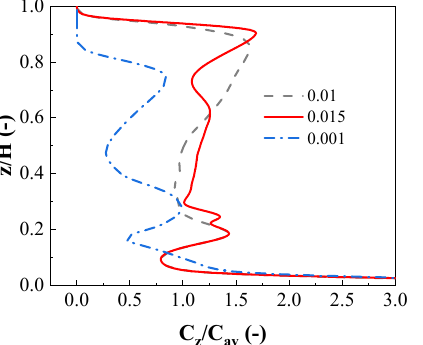
Figure 17. Effect of liquid viscosity on local axial solid concentration profile.